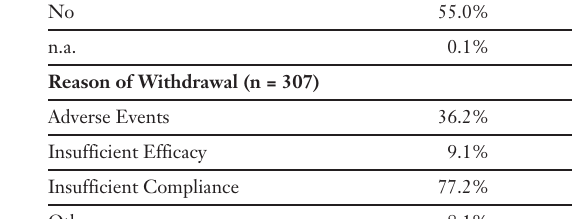
Withdrawal of medi- cation (n = 685).